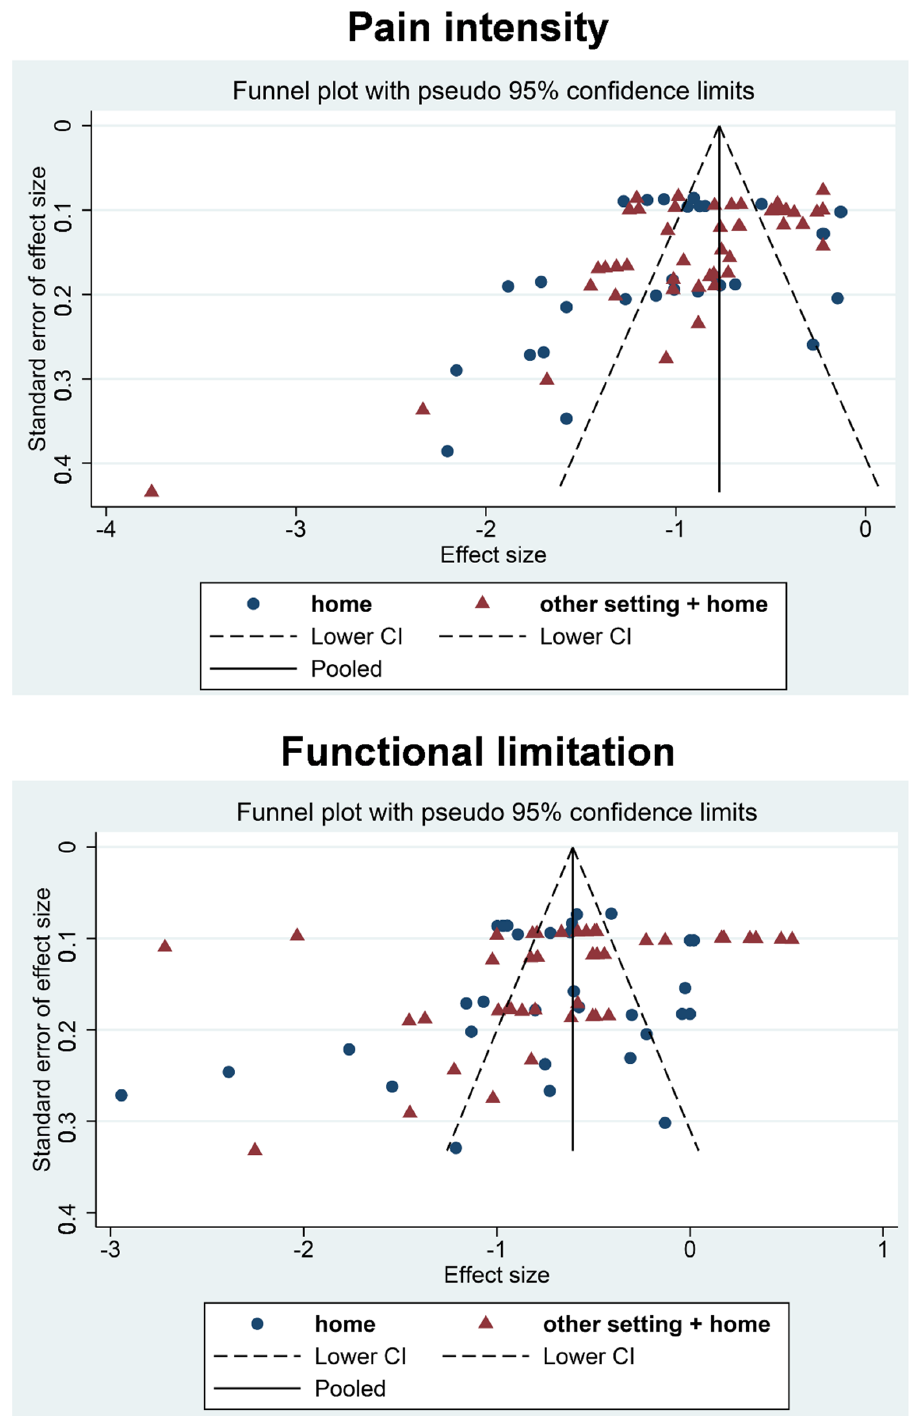
Figure A6. Funnel plot (meta-funnel) for effect size of home-based exercise on pain intensity and functional limitation, in low back pain. Each dot represents a single study, with its corresponding effect size ( x -axis) and its associated standard error of the effect estimate ( y -axis). Large high-powered studies are placed towards the top, and smaller low-powered studies towards the bottom. The plot should ideally resemble a pyramid or inverted funnel, with scatter due to sampling variation. Studies outside the funnel plot are likely to present bias.